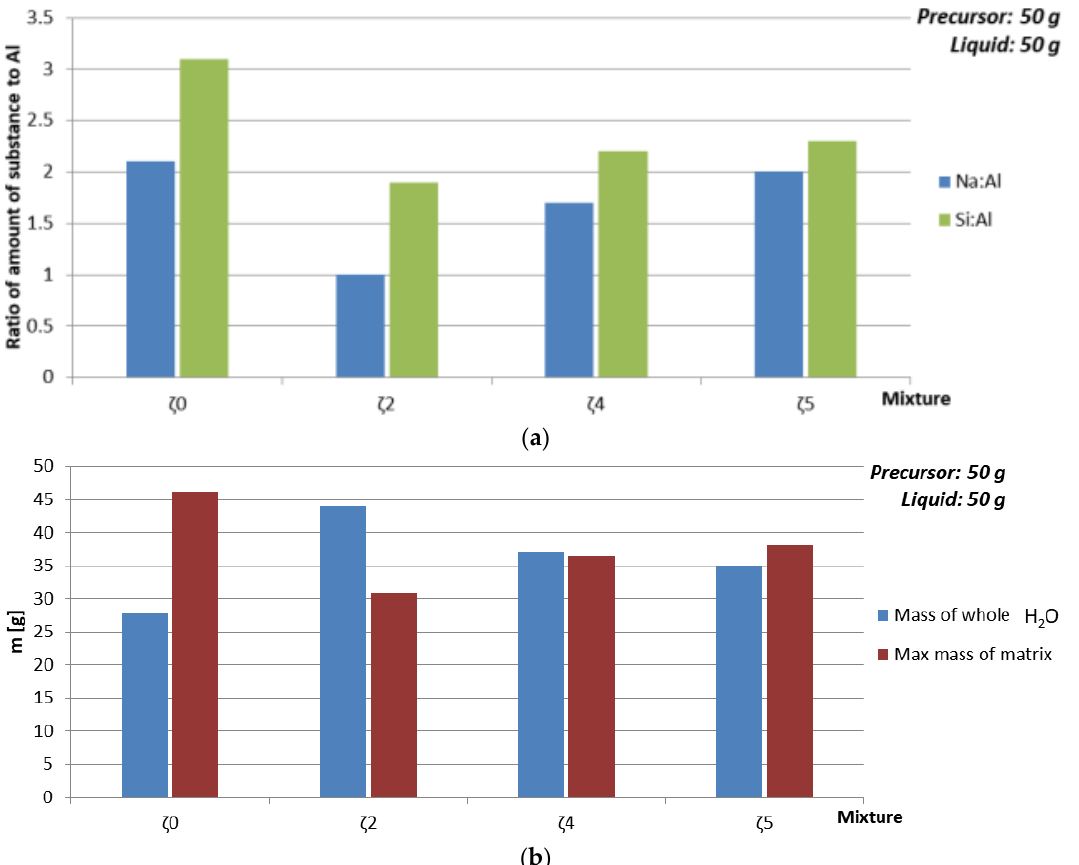
Figure 8. ( a ) Amount of substance according to amount of Al for Na and Si, ( b ) maximal mass of whole ASN and mass of whole water of AAM prepared with 50 g of mixtures ζ 0 , ζ 2 , ζ 4 , and ζ 5 , cured on 70 °C for one day.